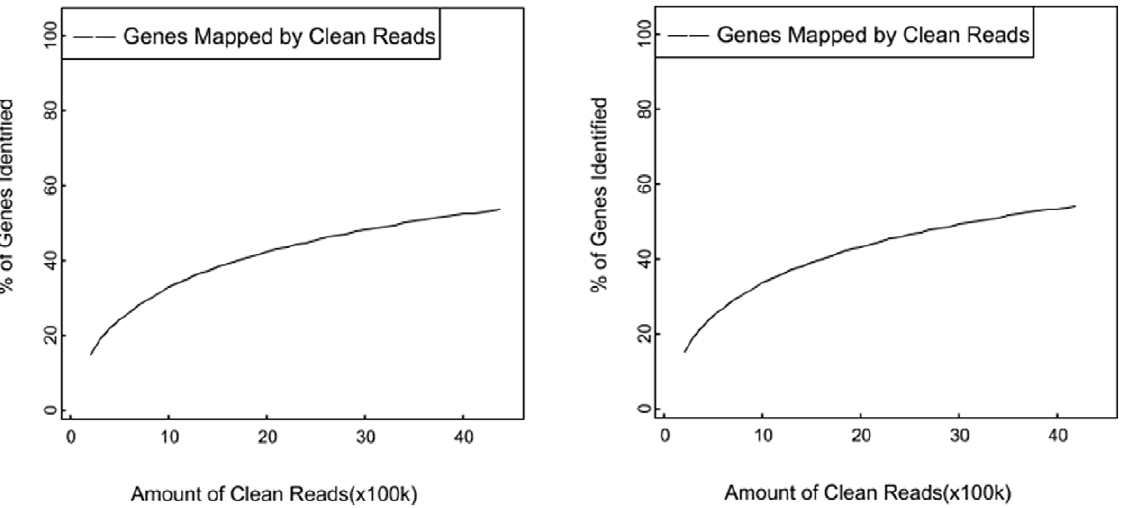
Figure 6. Sequencing saturation analysis. X-axis is number of clean reads, Y-axis is the percentage of identified genes. When the number of clean reads reaches about 4 M or higher, the number of detected genes almost ceases to increase. The left figure show the DGE of laying goose, the right figure show the DGE of broodiness goose. doi:10.1371/journal.pone.0055496.g006 PLOS ONE |